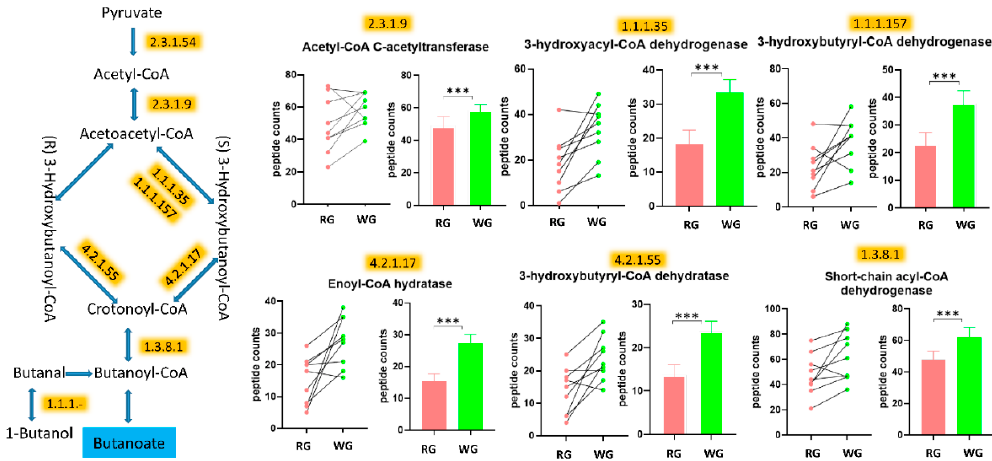
Figure 6. The WG diet led to enhanced metabolism of butyrate. The enzymes (highlighted) were